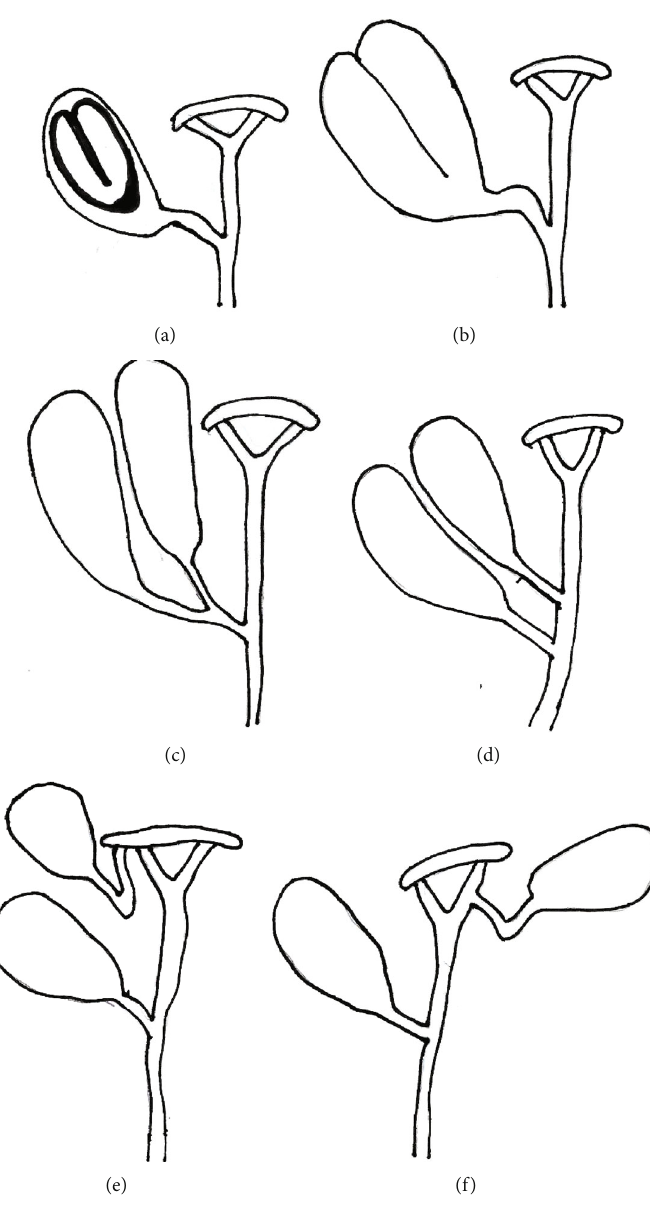
Figure 7: Classi fi cation of the duplication of the